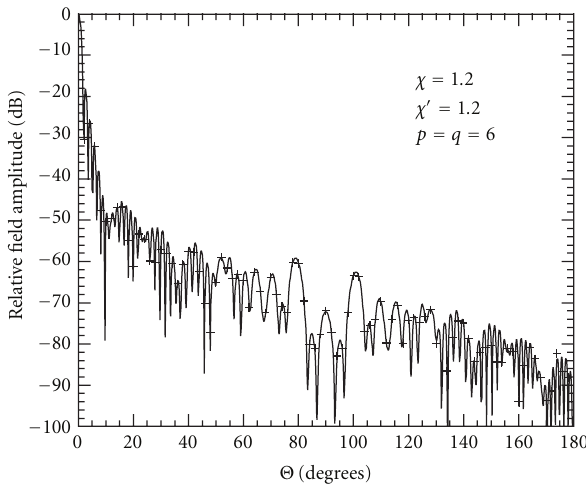
Figure 11: E-plane pattern. Solid line: exact. Crosses: reconstructed from NF data.